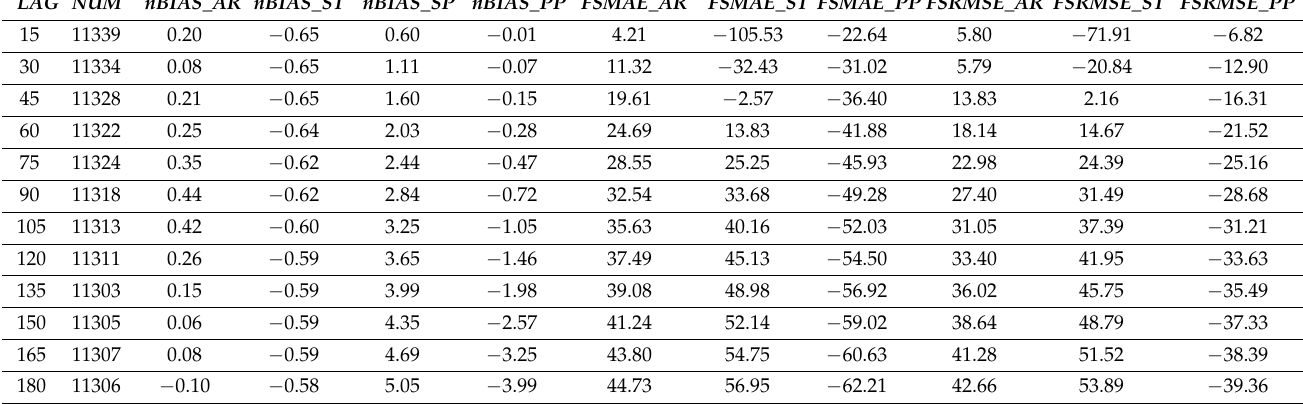
Table 8. Normalized BIAS and forecast skill related to MAE–FSMAE and RMSE–FSRMSE for plant P4 from 15 min up to three hours